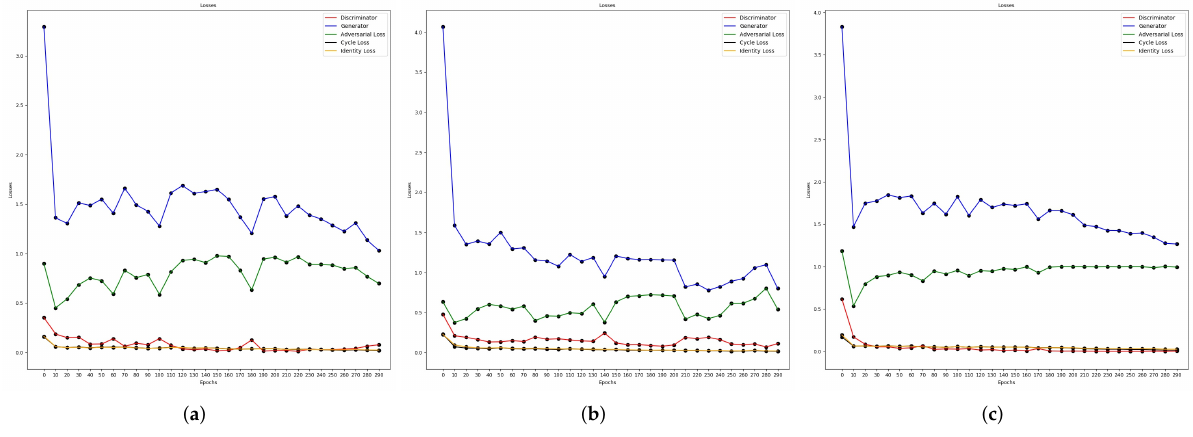
Figure 3. Comparison of training losses observed with the use of different optimizers. Note that the adopted AdaBelief effects the smoothest learning behaviour. ( a ) Adam; ( b ) SGD; ( c ) AdaBelief.